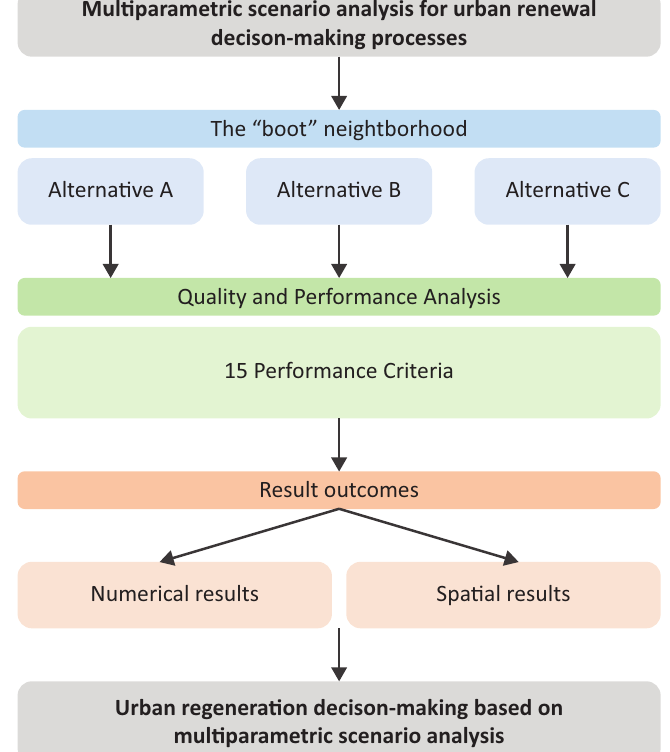
Figure 1. The research’s flow.